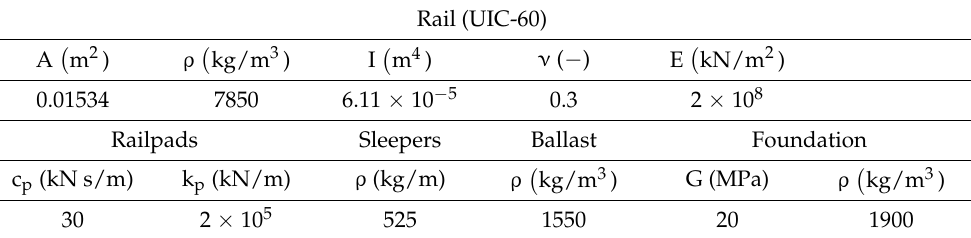
Figure 2. Track model. Table 1. Mechanical properties of the track model [26].